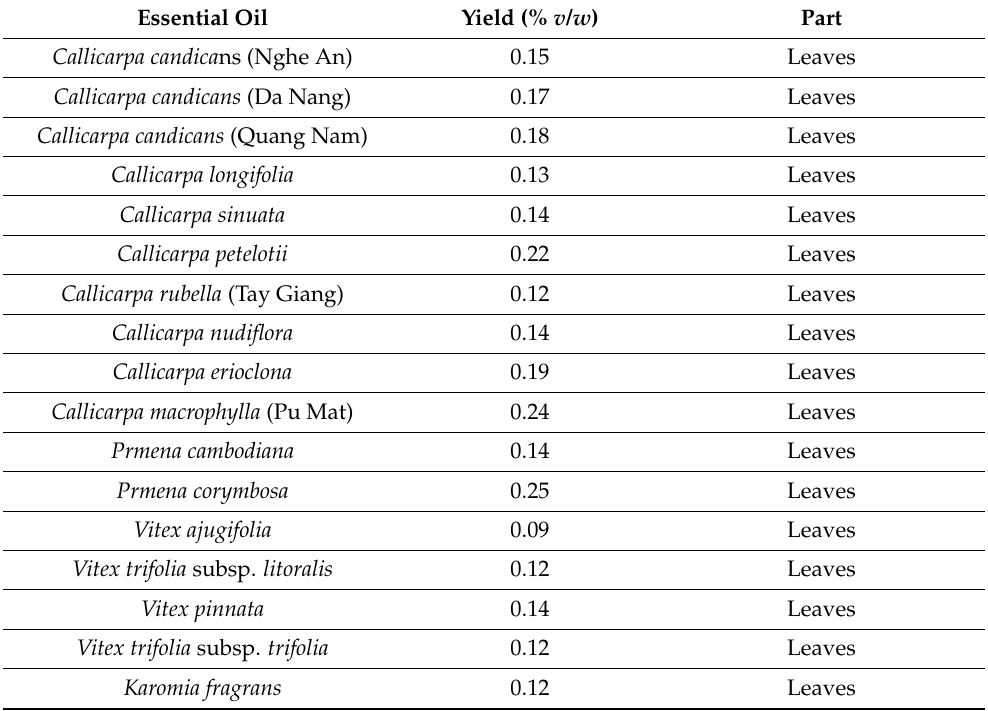
Table 8. Extraction yield of essential